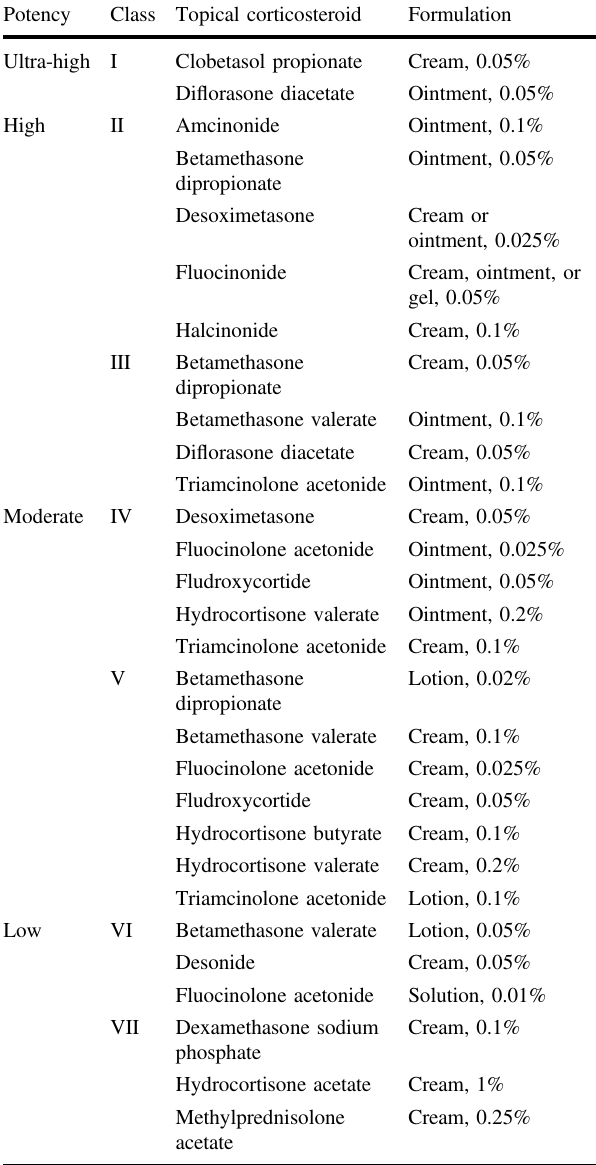
Table 1 WHO classi fi cation of TCS and commercial